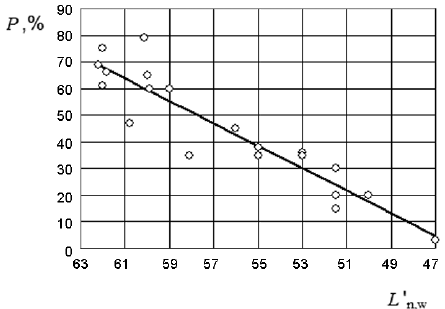
Fig. 7. Percentage of the occupants which evaluated their acoustic comfort level as poor depending on the floor’s weighted normalized impact sound pressure level L ’ n,w value (modified from Jagniatinskis